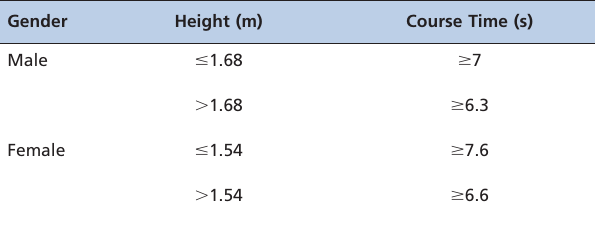
Table 3 - Gait speed cut-off points of individuals aged 65 years or older who were inhabitants of the northern region of Rio de Janeiro, Brazil in 2010.